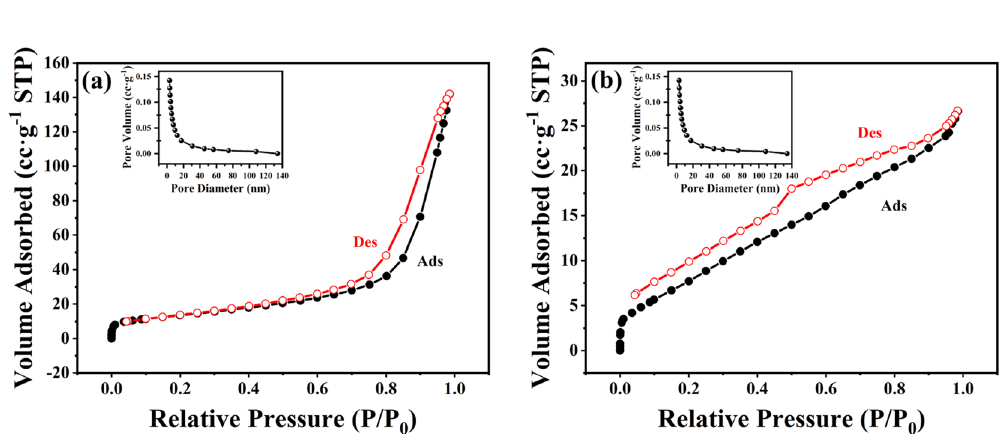
Figure 4. Adsorption–desorption curve of ( a ) HNTs and ( b ) ChNTs. Inset: Pore size distribution curve of ( a ) HNTs and ( b )